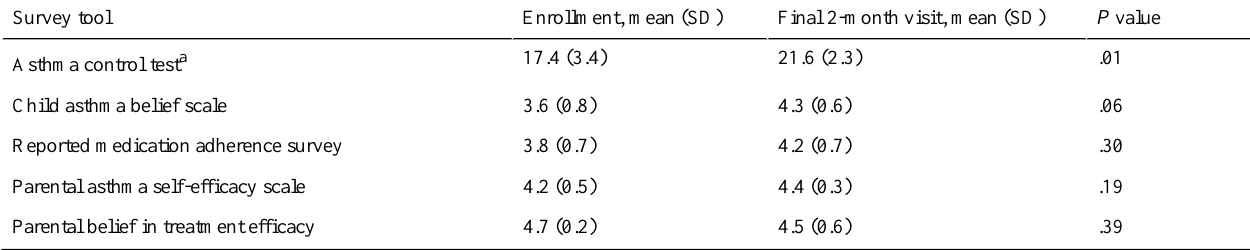
Table 3. Child and parent survey tools used in development phase 2